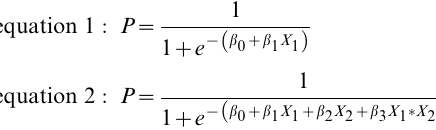
Figure S4 Flow cytometry gating strategy. Live cells were gated from total events by use of Viability Dye staining. From live cells, lymphocytes were gated based on morphology detected as forward and side scatter, FSC and SSC.